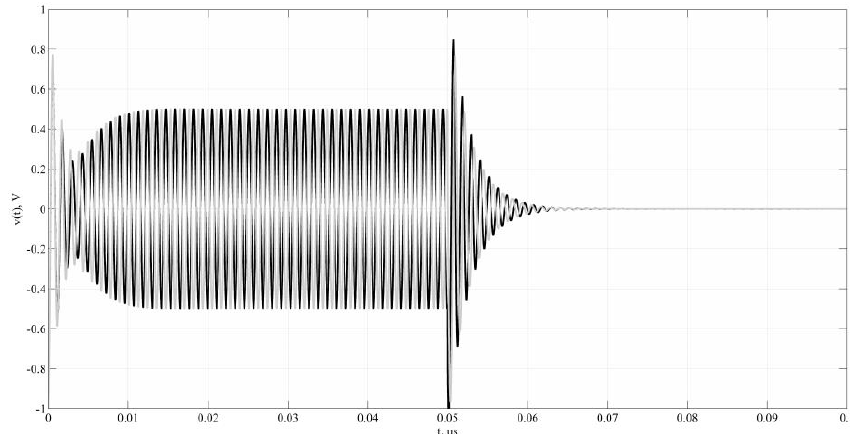
Fig. 5. Comparison of modulation states for PSK-2